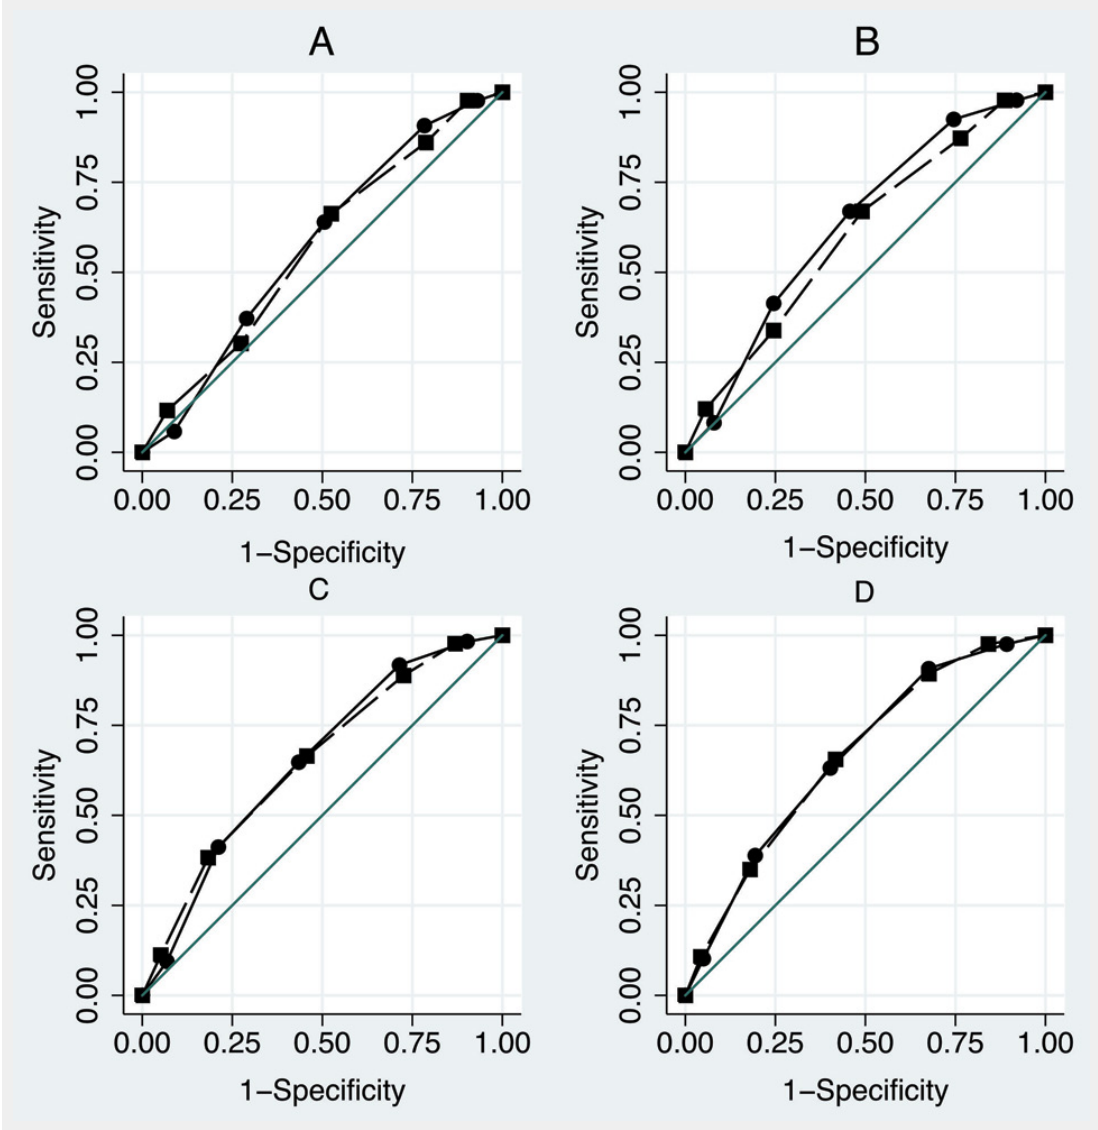
Figure 2 ROC curves of the Identification of a Senior at Risk (ISAR – plain circle line) and the Triage Risk Stratification Tool (TRST- long-dash square- line) for readmission at 1, 3, 6 and 12 months. A: 1 month ISAR ROC area = 0.612 - TRST ROC area = 0.607 B: 3 months ISAR ROC area = 0.655 - TRST ROC area = 0.621 C: 6 months ISAR ROC area = 0.660 - TRST ROC area = 0.651 D: 12 months ISAR ROC area = 0.664 - TRST ROC area =